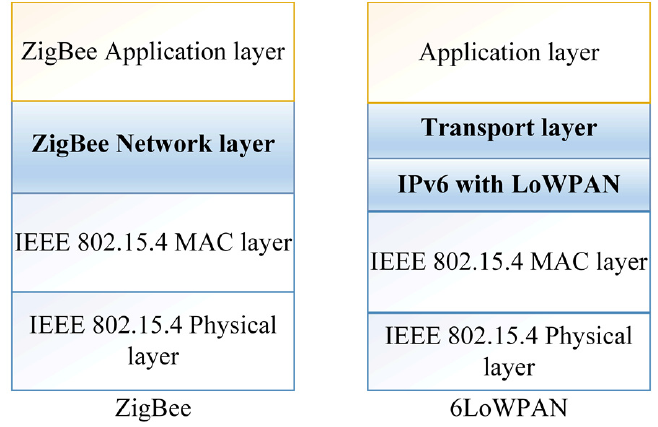
Figure 3. WSN co-management protocols.